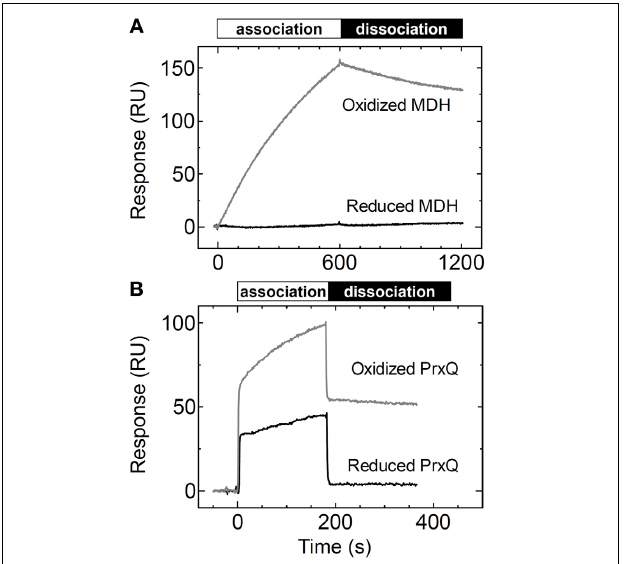
FIGURE 4 | Changes in affinity based on the redox states of the target proteins. (A) Reduced or oxidized MDH (5 μ M) was injected onto the Trx h 1 CS immobilized on a sensor chip and SPR signals were recorded. (B) Reduced or oxidized PrxQ (5 μ M) was injected onto the Trx h 1 CS immobilized on a sensor chip and SPR signals were recorded.